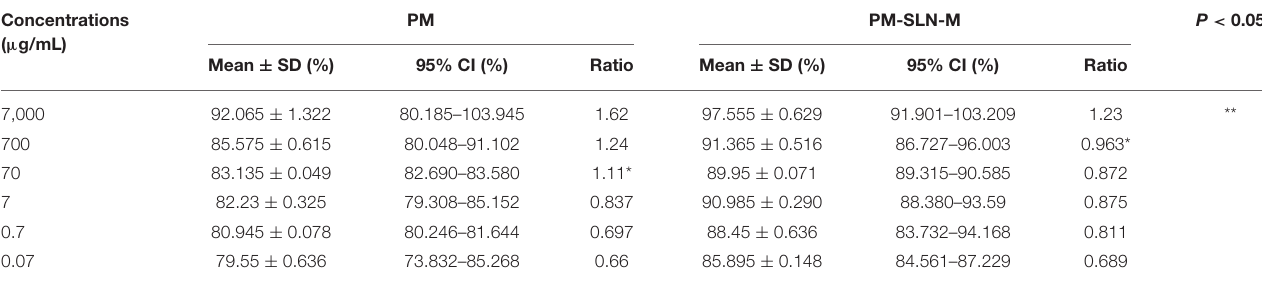
TABLE 3 | Anti- Toxoplasma activity of different concentrations of PM and PM-SLN-M and the ratio value of anti-parasite activity per Vero cell viability. Concentrations ( µ